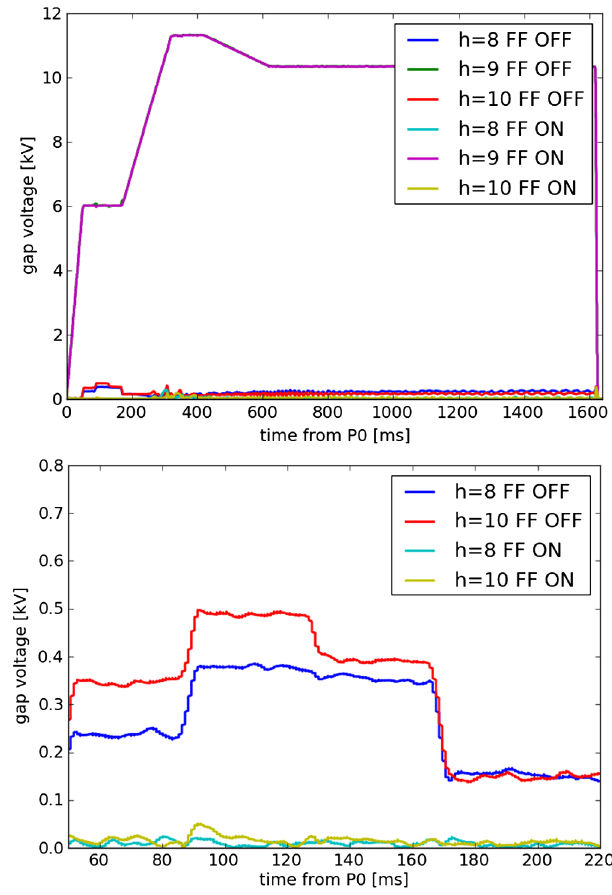
FIG. 10. A comparison of the harmonic components of cavity #8 gap voltage without and with feedforward; (top) full accel- erating cycle; (bottom) magnified plot during injection